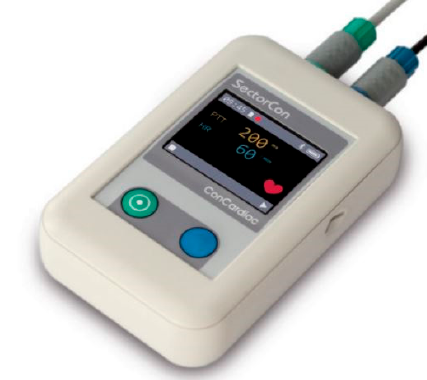
Figure 2. Data collection device for the PES/PCS system.